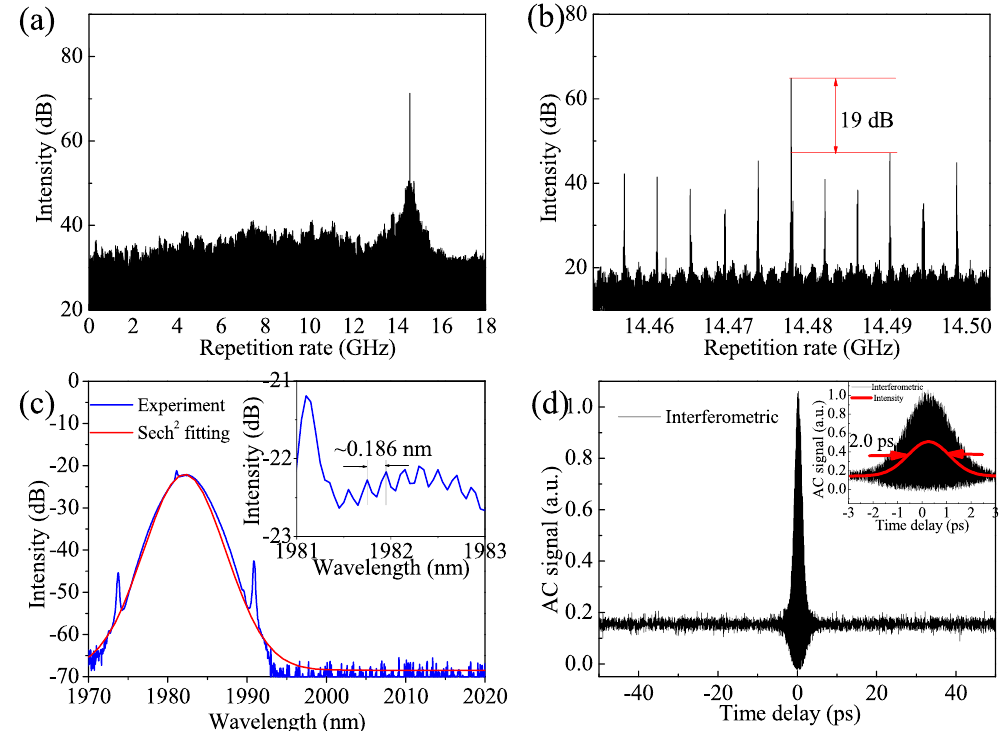
Figure 1. HML at repetition rate of 14.5 GHz: ( a ) and ( b ) are RF spectra with a scanning range of 18 GHZ and 50 MHz, respectively; ( c ) optical spectrum with 0.05 nm resolution, inset is a zoom of the spectrum; ( d ) interference autocorrelation with a scan range of 100 ps. Inset of ( d ) is interference and intensity autocorrelation with sech2-pulse fitting in a scan range of 6